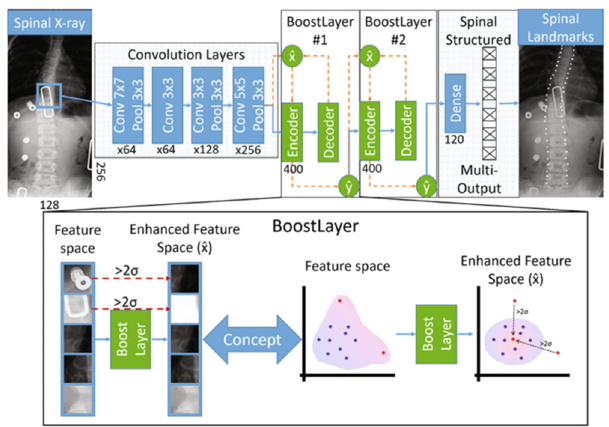
Figure 6. The structure of Boostnet [65]. The Boostnet consists of three parts: a convolutional layer for feature extraction, a boostlayer for removing outliers, and a multi-output layer for relieving the pressure of small datasets by capturing inter-landmark dependencies.